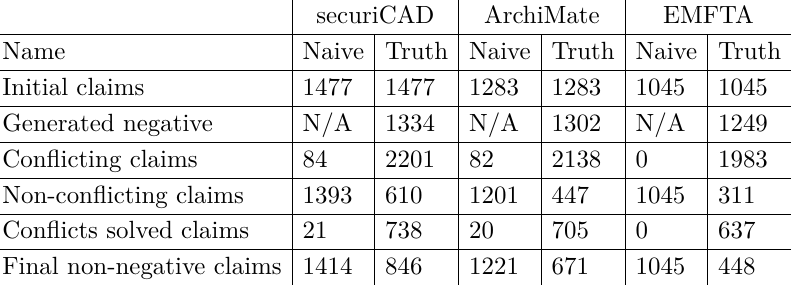
Table 7. Claims from all the data sources included in the analysis. N/A denotes Not